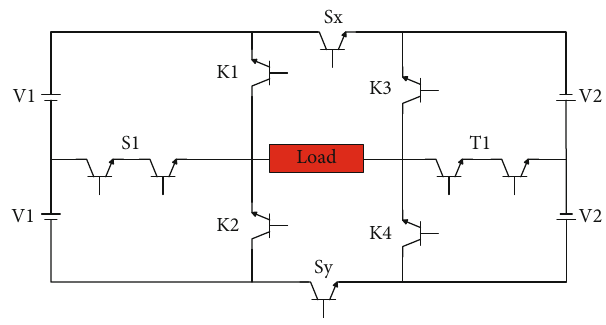
Figure 1: 7-level MLI. Figure